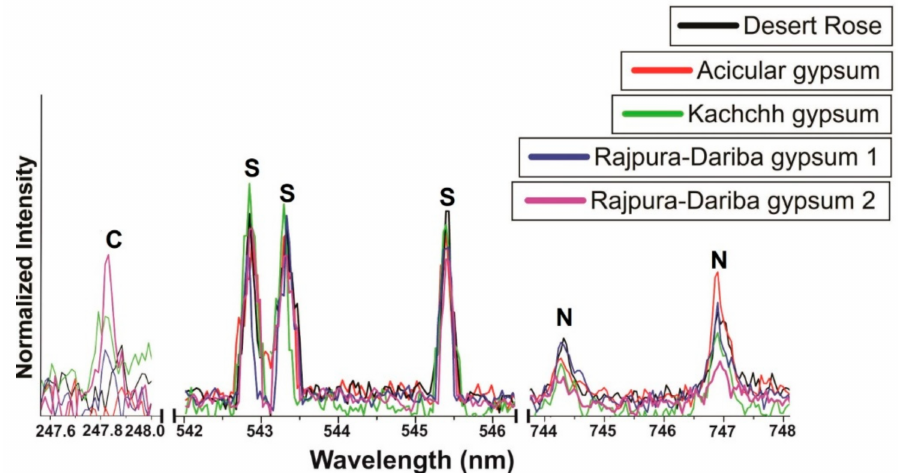
Figure 7. Spectral regions of recorded C, S, and N atomic data for the gypsum